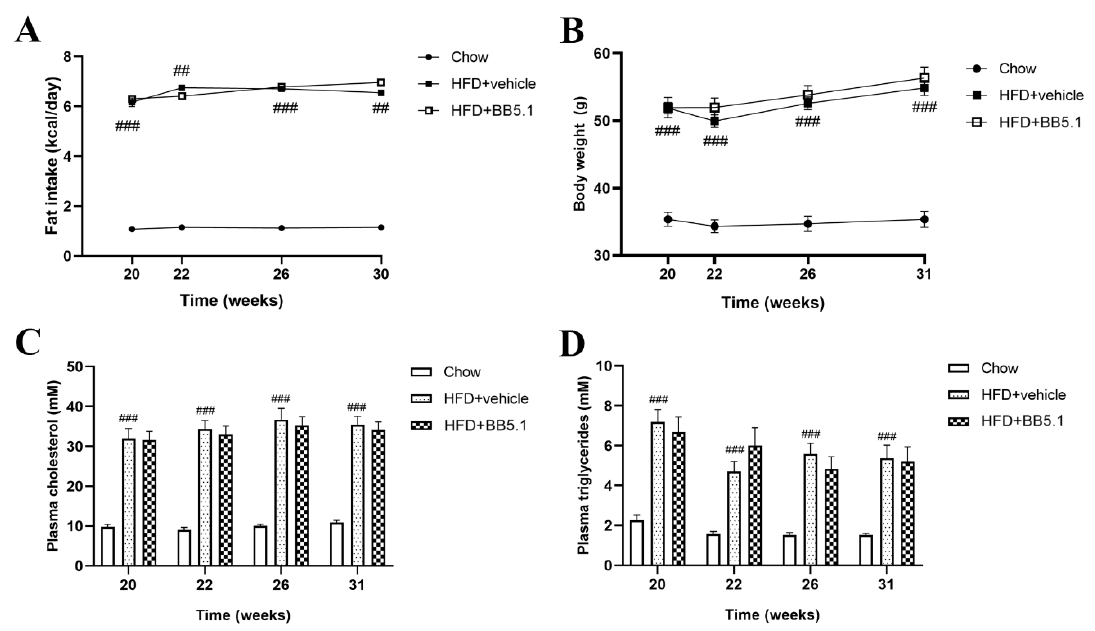
Figure 3. Anti-C5 treatment does not affect HFD-induced obesity and its metabolic risk factors. ( A ) Fat intake, ( B ) body weight, ( C ) plasma total cholesterol and ( D ) triglyceride concentrations are increased by HFD feeding and not altered by the anti-C5 treatment. Data are mean ± SEM. ## p ≤ 0.01, ### p ≤ 0.001 Chow vs. HFD+vehicle.